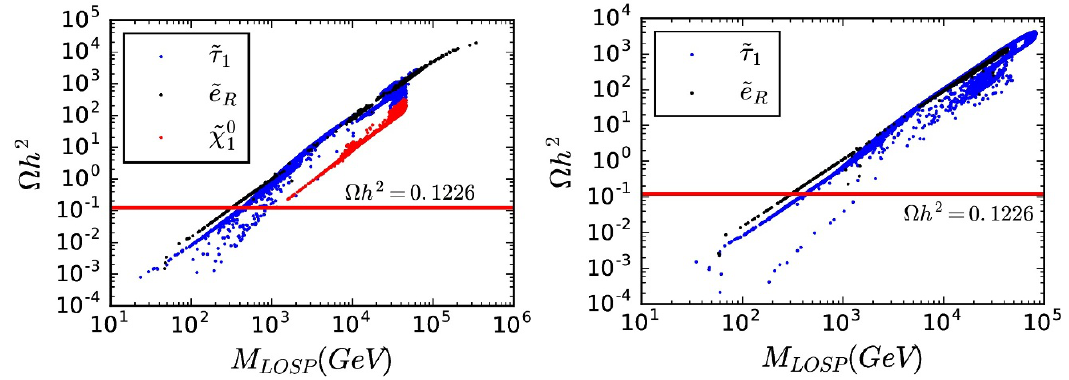
Figure 6 . The relic abundances of various LOSP particles for a = 3(left panel) and a = 2(right panel) in scenario